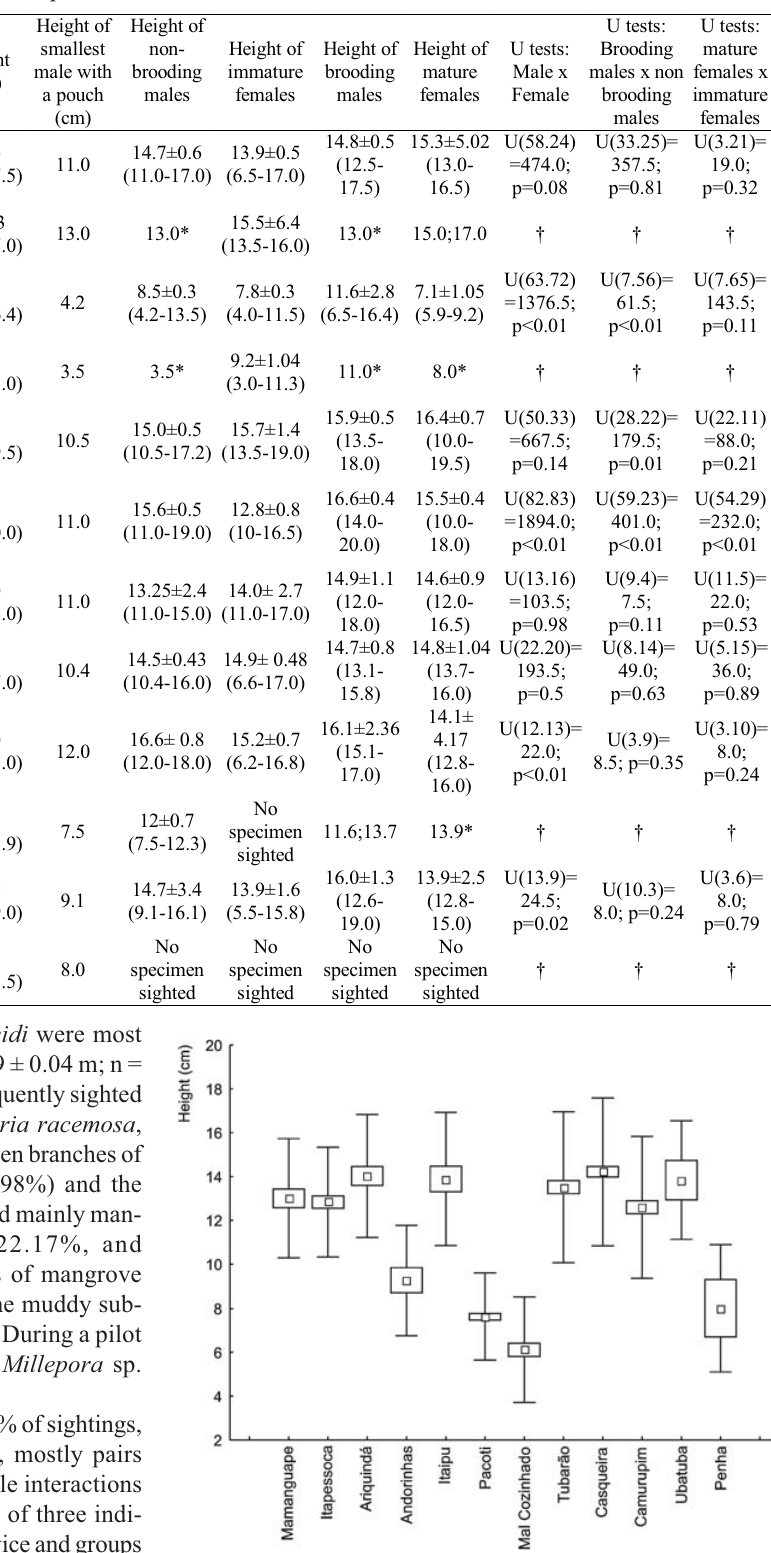
Table 2. Population data used by Hippocampus reidi in 12 Brazilian localities. Means ± confidence interval (range); * only one specimen sighted; † Not compared, due to low sample size.